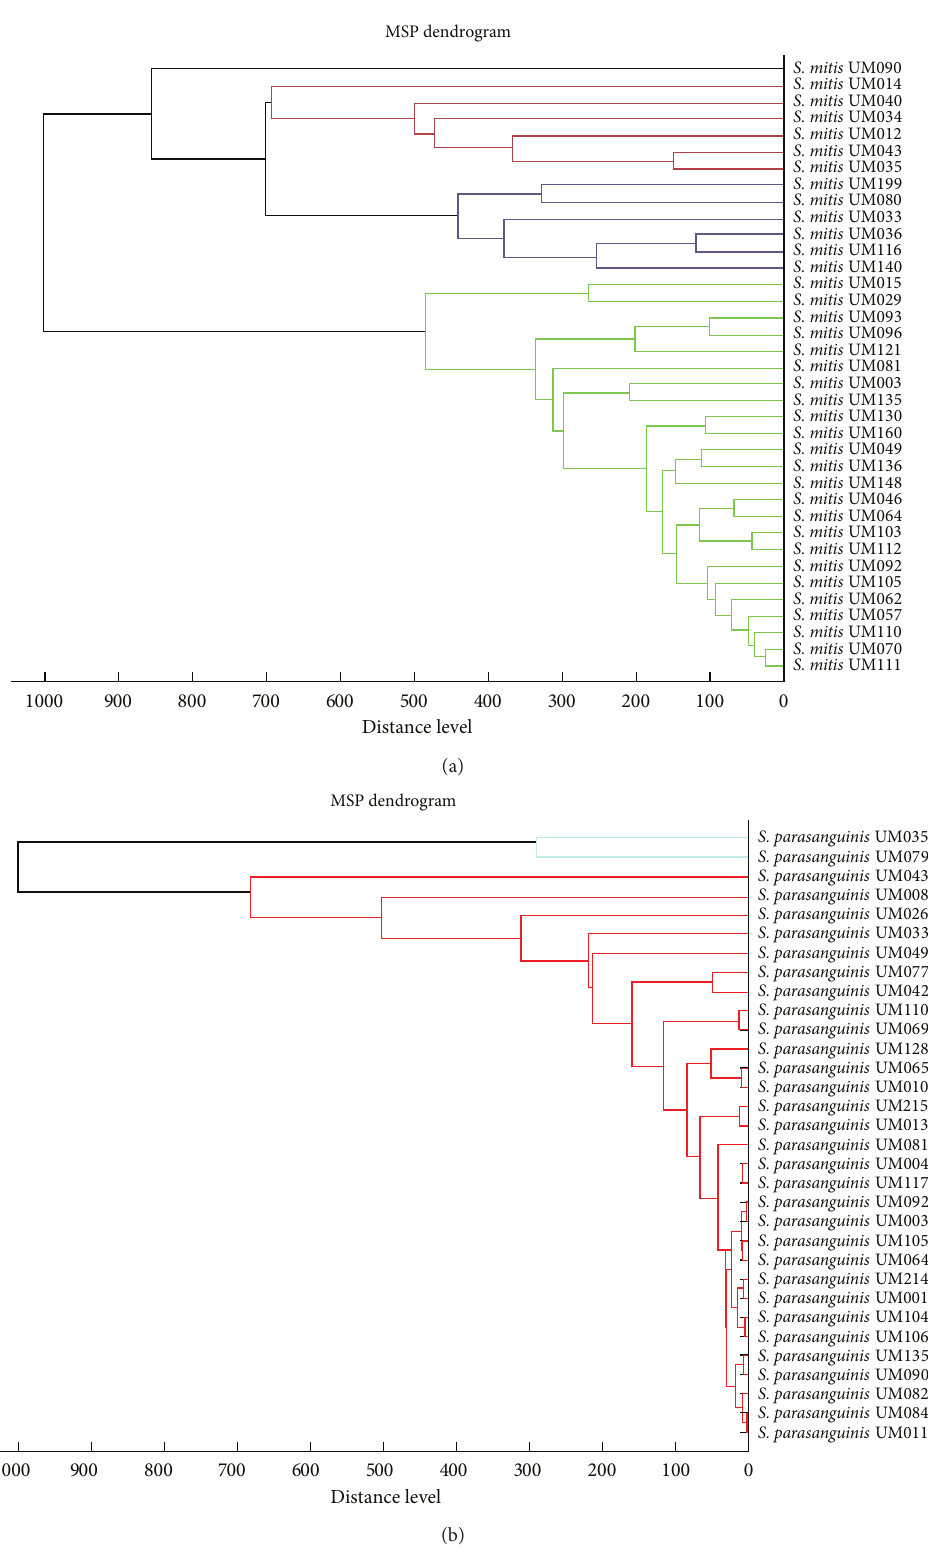
Figure 1: Dendrograms for clinical isolates of (a) S. mitis and (b) S. parasanguinis generated based on protein fingerprinting using Biotyper